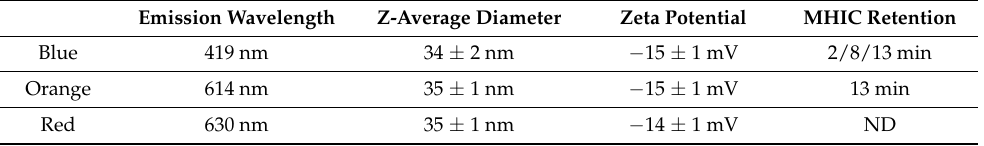
Table 1. Physical properties of different nanoparticles used in this